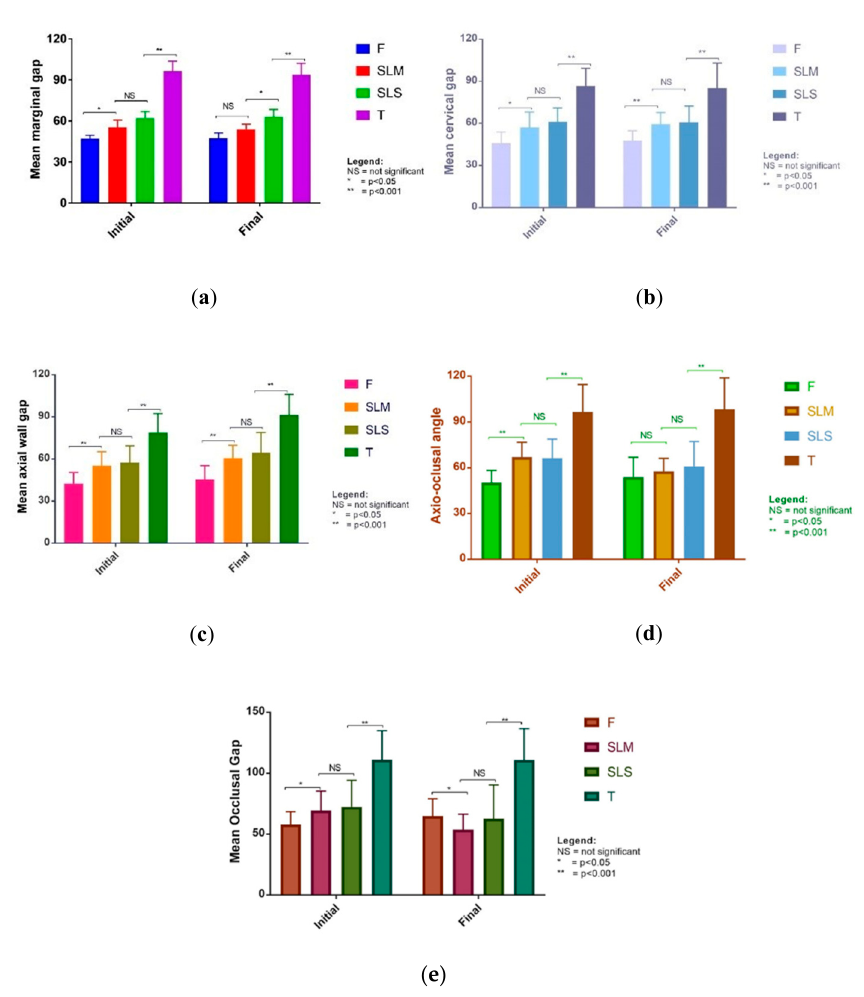
Figure 7. Obtained results: initial and final measurements ( a ) mean marginal gap; ( b ) mean cervical gap; ( c ) mean axial wall gap; ( d ) mean axio-occlusal angle; ( e ) mean occlusal gap.